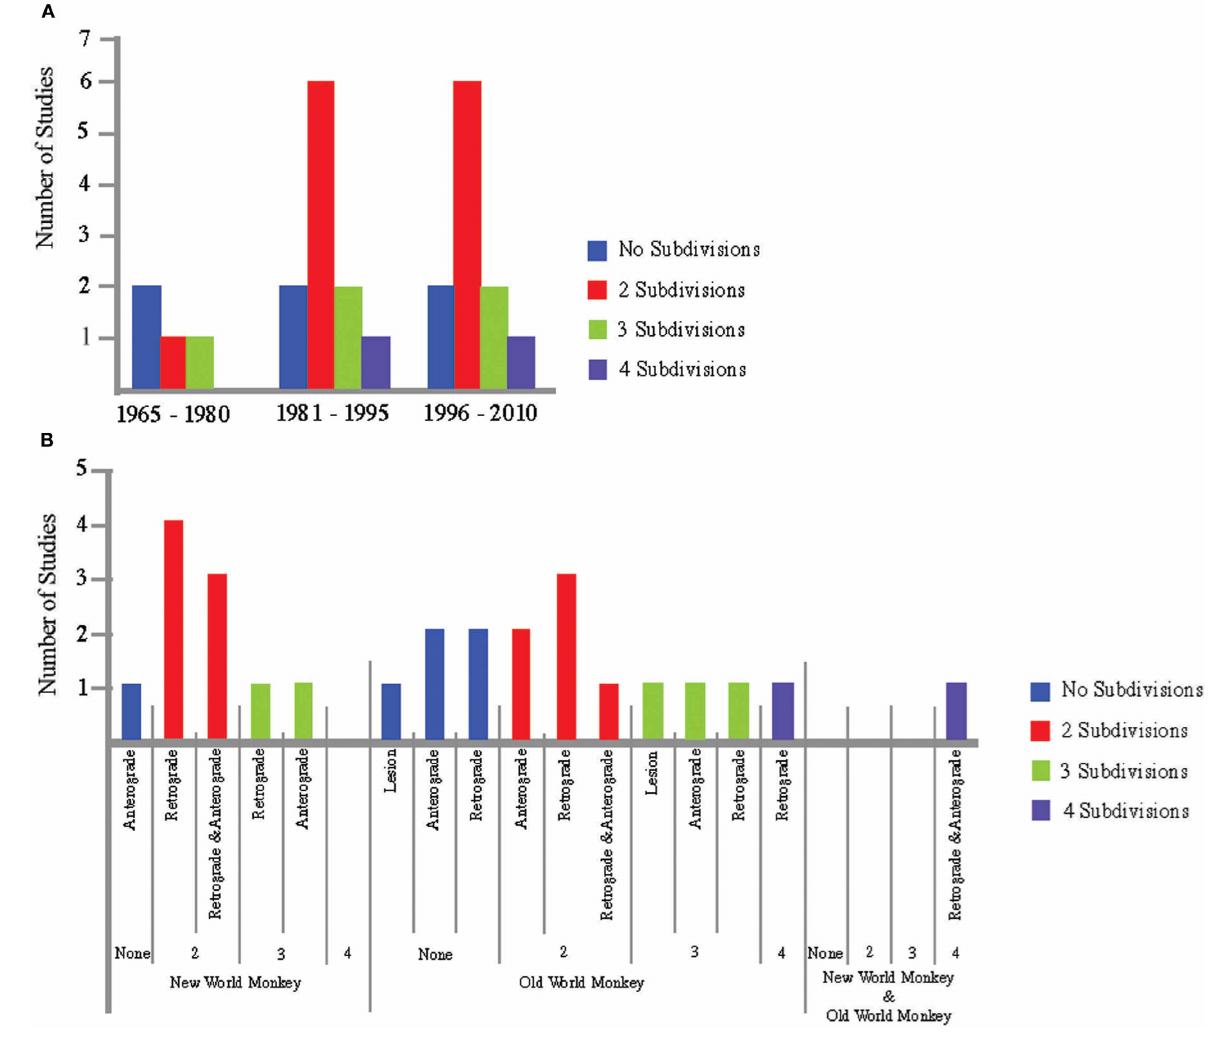
(a) the type of tracer used, and (b) the species under investigation. Color indicates the number of subdivisions reported. Blue bars indicate no subdivisions, red bars indicate two subdivisions, green bars indicate three subdivisions and purple bars indicate four